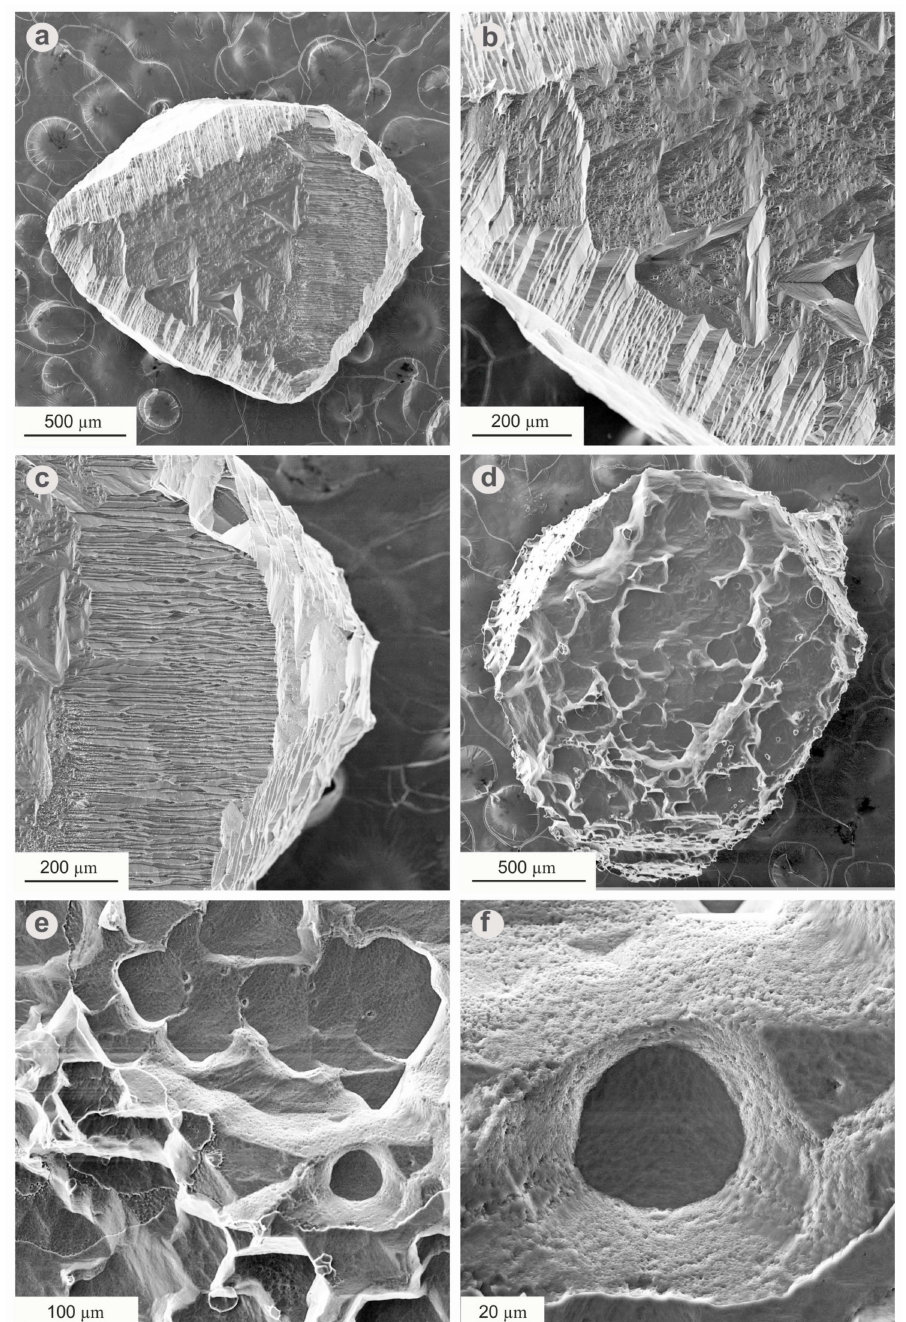
Figure 3. Diamond crystals etched at 1130 ◦ C in air for 15 min ( a – c ) and in a basaltic melt exposed to air for 60 min ( d – f ). ( a ): general view; ( b ): fragment of an octahedral face with trigons; ( c ): fragment of a crystal with newly formed trisoctahedroidal surfaces; ( d ): general view; ( e ): fragment of an octahedral face with trigonal and hexagonal pits; ( f ): a hexagonal (nearly round) pit on an octahedral